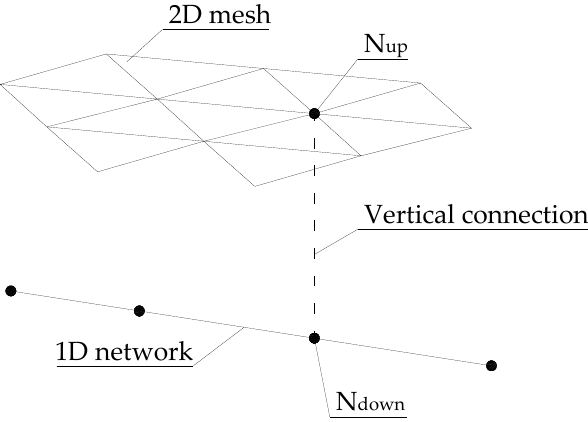
Figure 1. 1D-2D computational grids coupling.